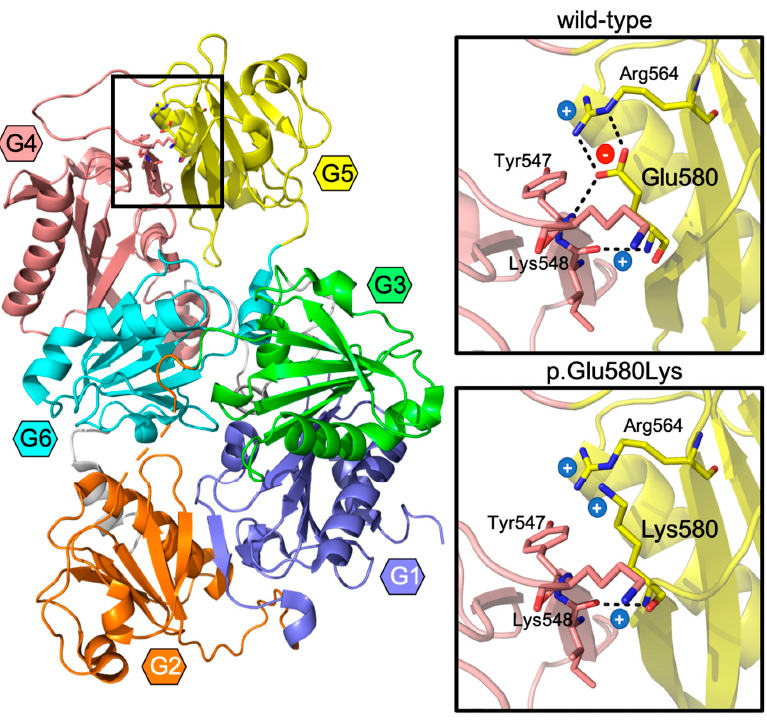
Figure 4. The impact of the mutation on the structure of the protein. Gelsolin protein is organized in 6 homologous domains, labeled G1 to G6 and uniquely colored in the figure. The p.Glu580Lys substitution locates at the G4–G5 interface, highlighted by the frame. A close-up view of this area in the wild-type and mutated protein is reported in the insets, where residue 580 and those interacting are represented as sticks and labeled. Electrostatic interactions and H-bonds are displayed as dashed lines; positively and negatively charged residues are marked by a blue (+) and red ( − ) symbol, respectively.